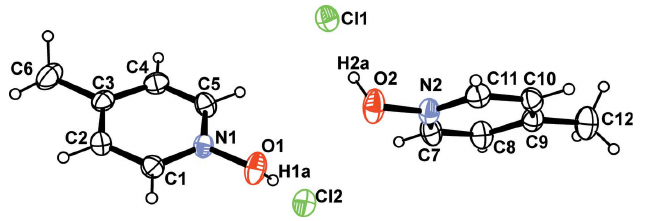
Figure 1 ORTEP diagram of 1 with 50% displacement ellipsoid probability